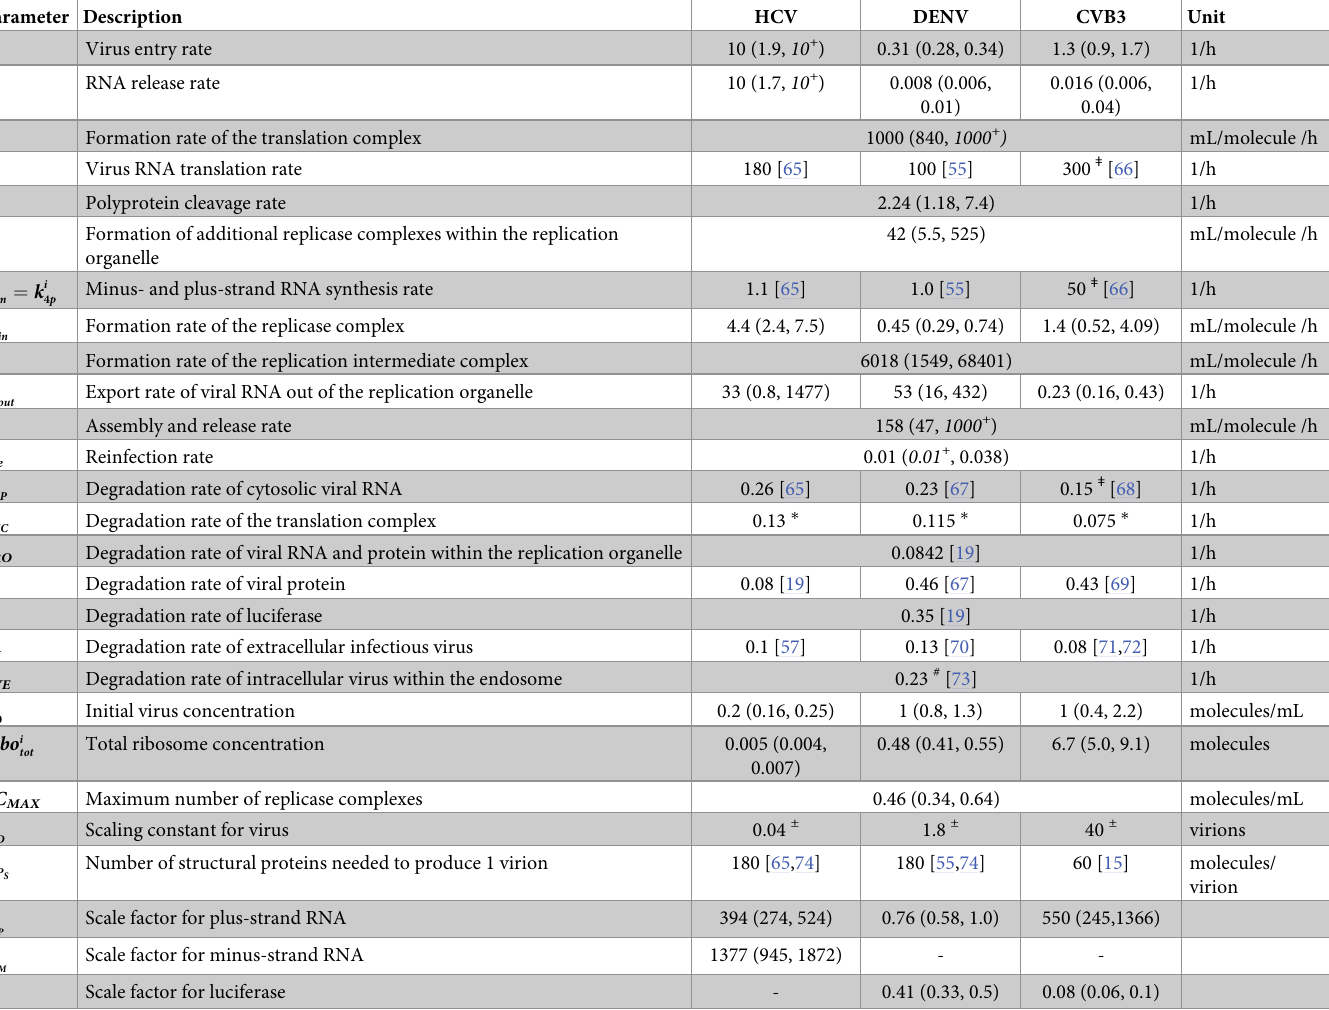
Table 2. Parameter values and 95% confidence intervals in (). Note that parameter values marked with * were fixed due to previous assumptions and calculations. Fur- thermore, confidence intervals marked with + hit the set estimation boundary; ± calculated from the data; # experimentally measured for Zika virus; ǂ experimentally mea- sured for poliovirus.